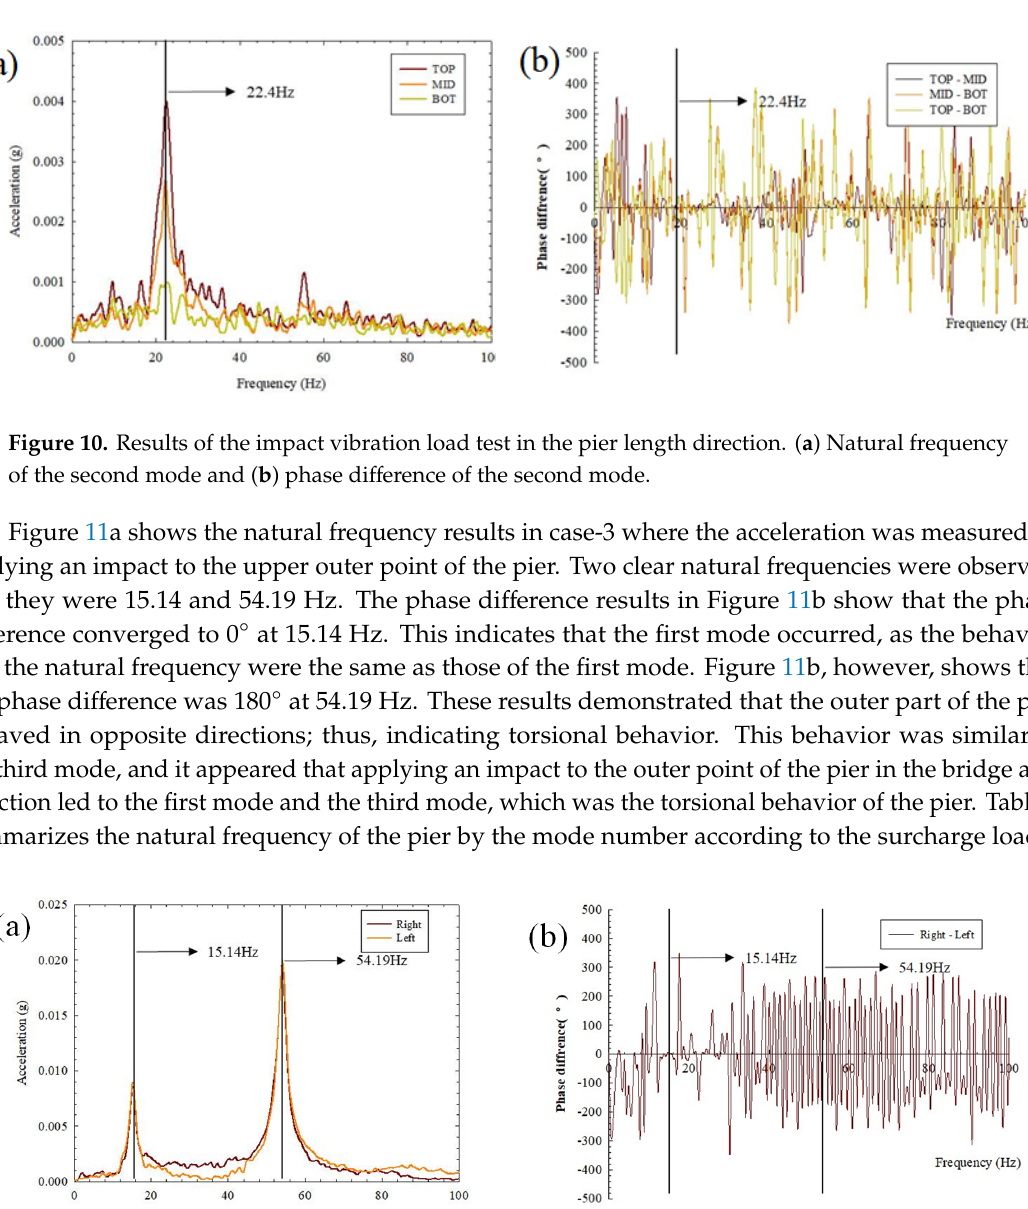
Figure 9. Results of the impact vibration load test in the bridge axis direction. ( a ) Natural frequency of the first mode and ( b ) phase difference of the first mode.